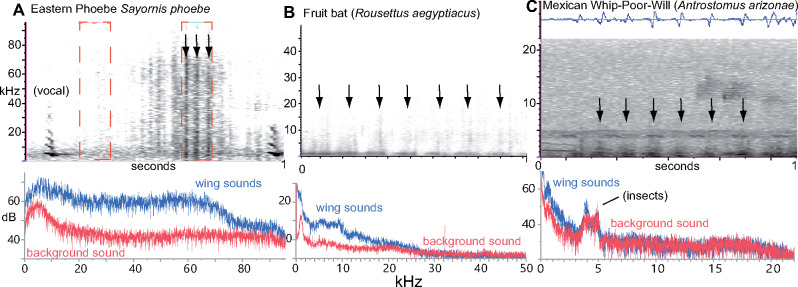
Wing sounds of a A) passerine, B) megachiropteran bat, and C) nightbird (Caprimulgidae). Graph A shows broadband wing sound up to 70 kHz; Graphs B and C show reduced broadband sound and virtually no ultrasound. Vertical arrows indicate individual wingbeats. Bottom power spectrum of wing sounds (blue) and background sound from the same recording (selected as in red dashed boxes in A). A) Eastern Phoebe flight sound recording courtesy Jayne Yack (Fournier et al. 2013) (FFT settings: 200 kHz, Hann, 4096 sample window, see Fournier et al. 2013 for dB calibration), recorded <0.5 m from the animal. B) Egyptian Fruit Bat (Rousettus aegyptiacus: Megachiroptera), recording courtesy Yossi Yovel (Boonman et al. 2014), from a microphone attached to the animal (FFT settings: 100 kHz, Hann, 2048 sample window, dB not calibrated). C) Mexican Whip-Poor-Will (Antrostomus arizonae) taking flight near a nest, recorded by a microphone placed approx. 1 m from nest. Top: individual wing-beats are clearly visible in wave-form. Recording courtesy Nathan Pieplow; 44.1 kHz, 512 sample window, dB not calibrated.